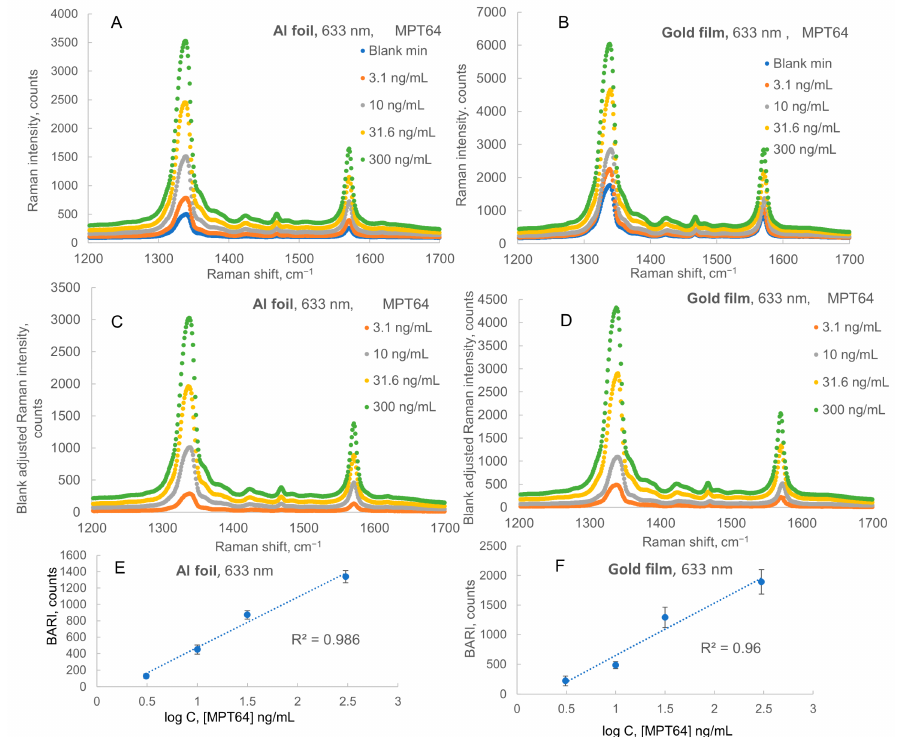
Figure 1. Raman spectra and calibration for sandwich immunoassay of MPT64 on Al foil and gold film with 633 nm excitation. ( A , B ) Spectra of Raman intensity on Al foil and Au film, respectively. ( C , D ) Blank-adjusted Raman intensity (BARI, counts) on Al foil and Au film, respectively. ( E , F ) Loga- rithmic calibration plots (BARI vs. decimal logarithm of MPT 64 biomarker concentration (ng/mL)) on the same substrates, respectively, with correlation coefficients R 2 for each